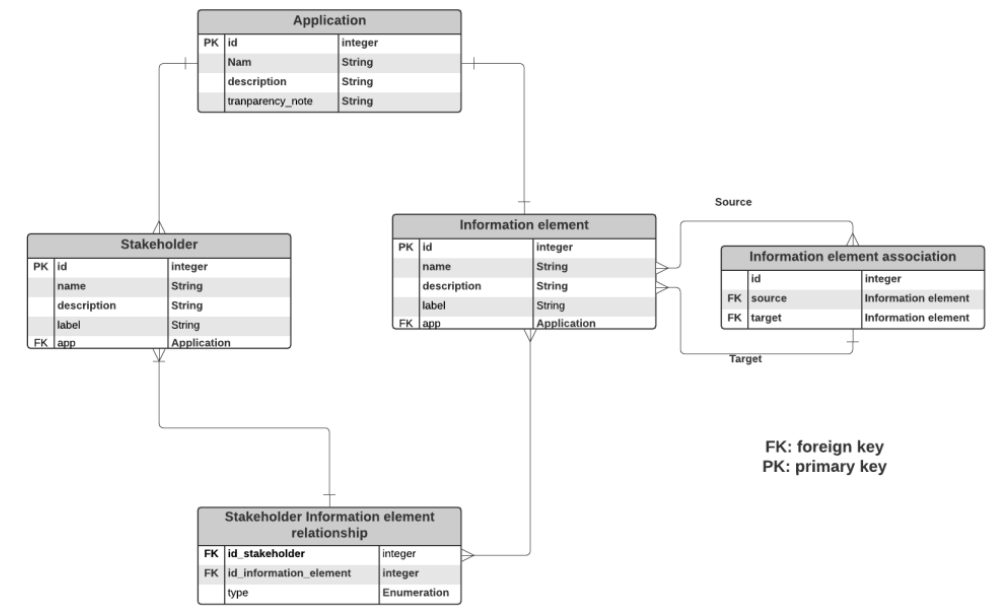
Figure 1. T RANSP V IS database